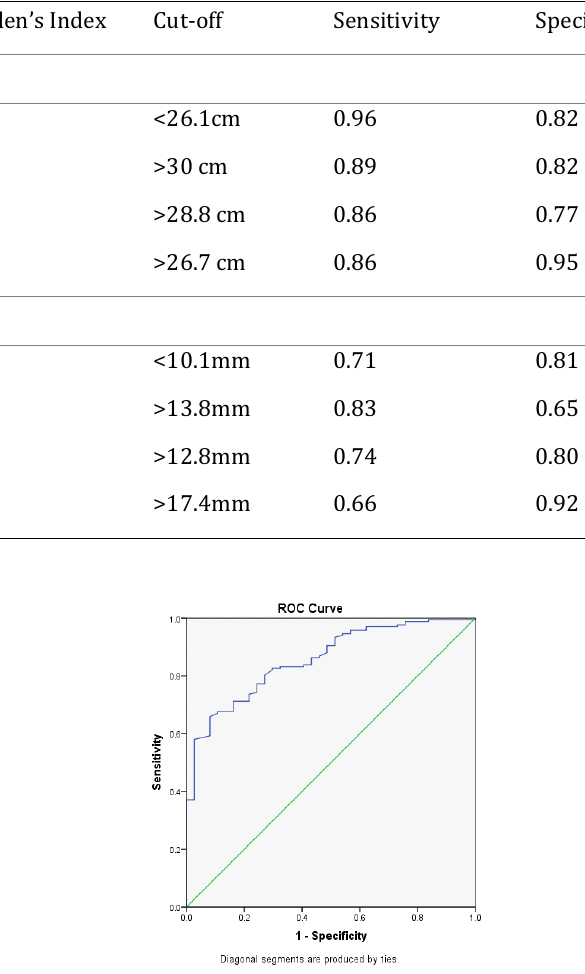
2c - ROC curve of TSFT in predicting